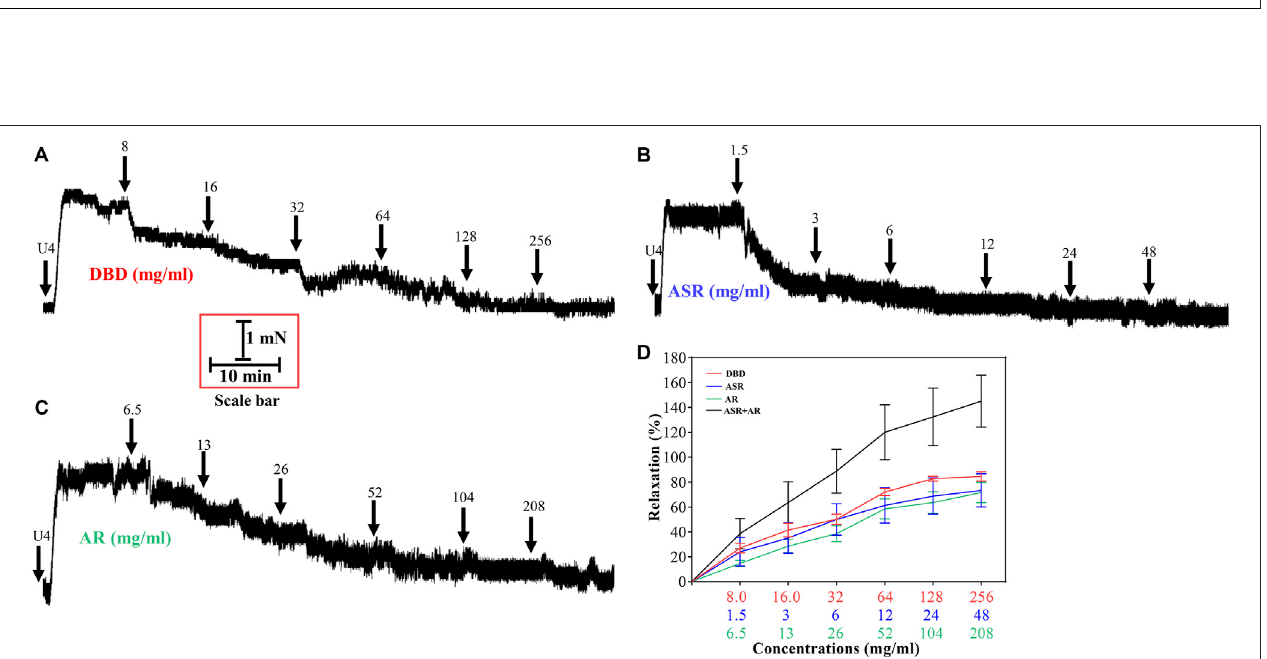
FIGURE 8 | Effect of DBD and its compatibility ratio of ASR and AR monotherapy on vascular tension of MCA under 1 μ M U46619 precontraction condition. DiagramsoftheeffectofcumulativeadditionofDBD (A) ,ASR (B) ,andAR (C) onU46619preconstrictedMCAofrats (D) Comparison ofvasodilatorsbyDBD,ARS,and AR on MCA of rats. Data were expressed as the mean ± S.E.M. (n (cid:2) 5). DBD, Danggui Buxue decoction. ASR, Angelicae Sinensis Radix. AR, Astragali Radix. MCA, middle cerebral artery.